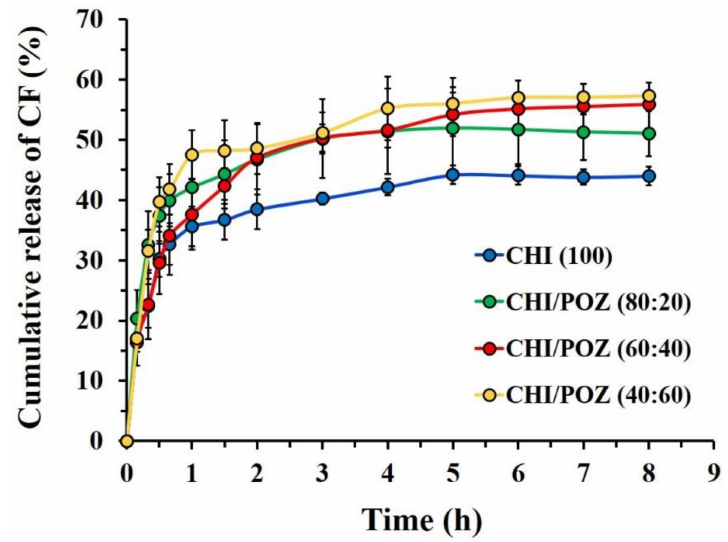
Figure 2. In vitrocumulativereleaseofciprofloxacinfromchitosan(CHI)andchitosan / poly(2-ethyl-2-oxazoline) (CHI / POZ) films with different polymer ratios. Data are presented as mean ± standard deviation (n = 3).